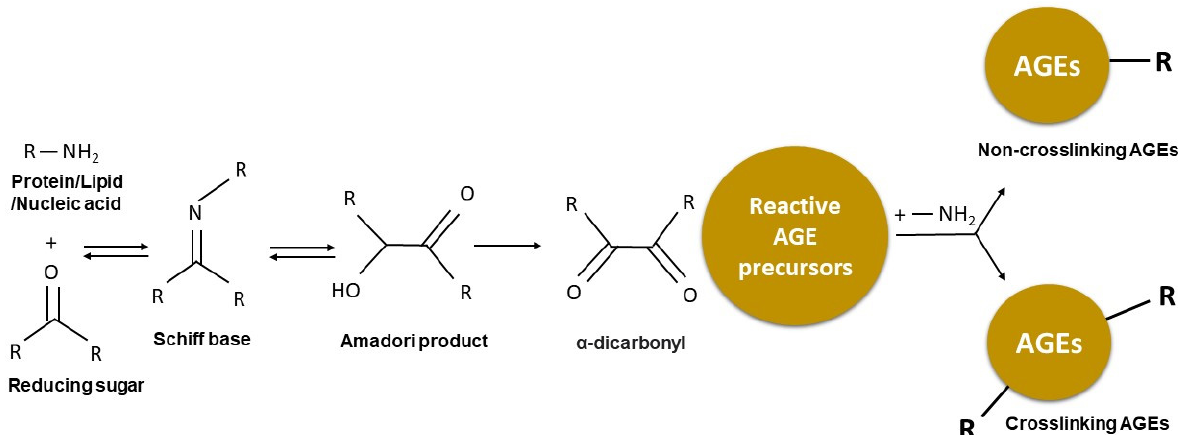
Figure 1. Overview of the Maillard reaction leading to the formation of advanced glycation end- products (AGEs). The Maillard reaction occurs when a carbonyl group is exposed to an amine, leading to a Schiff base formation, followed by Amadori rearrangement and formation of Amadori products. The Amadori products undergo irreversible oxidation, dehydration, enolisation, cyclisation, and fragmentation that lead to the formation of reactive intermediate AGE precursors. Reactive AGE precursors interact with protein-bound lysine or arginine to form AGEs, which can be classified as crosslinking or non-crosslinking.